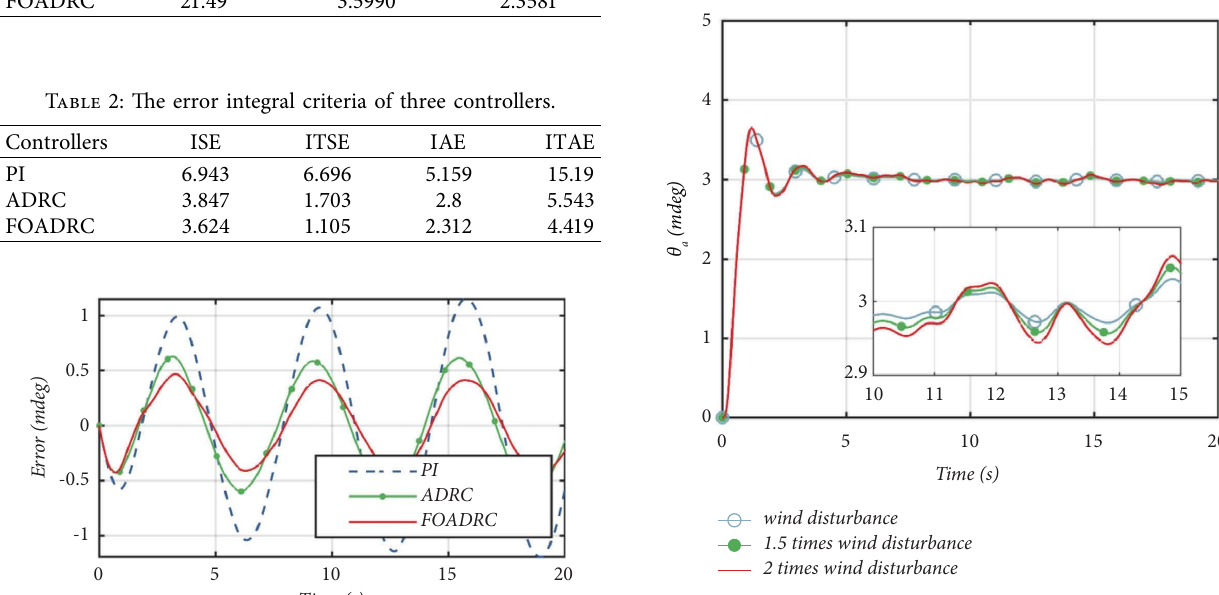
Figure 20: Te step response of the ADRC controller when wind disturbance is